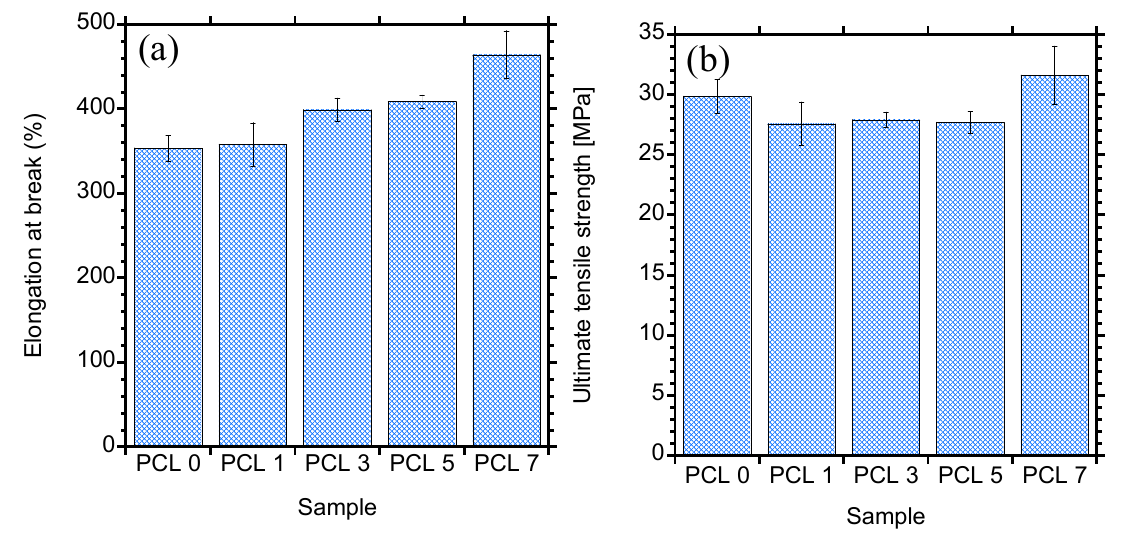
Figure 9. ( a ) Tensile strain and ( b ) ultimate tensile strength curves of PCL and PCL/HAP composites.